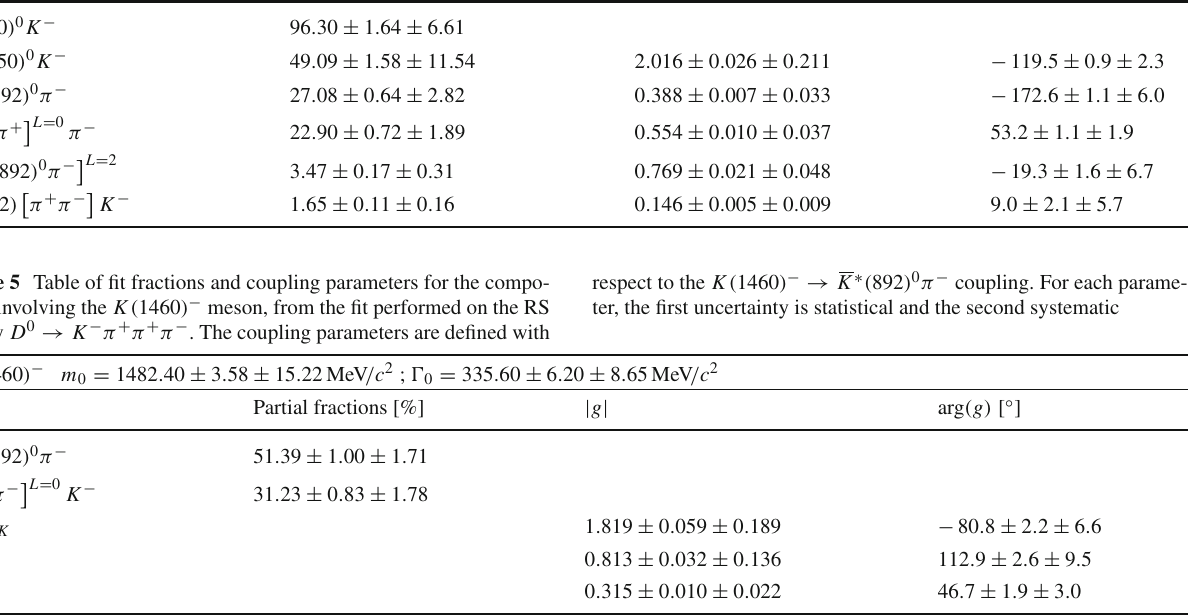
respect to the K 1 ( 1270 ) − → ρ( 770 ) 0 K − coupling. For each parame- ter, the first uncertainty is statistical and the second systematic